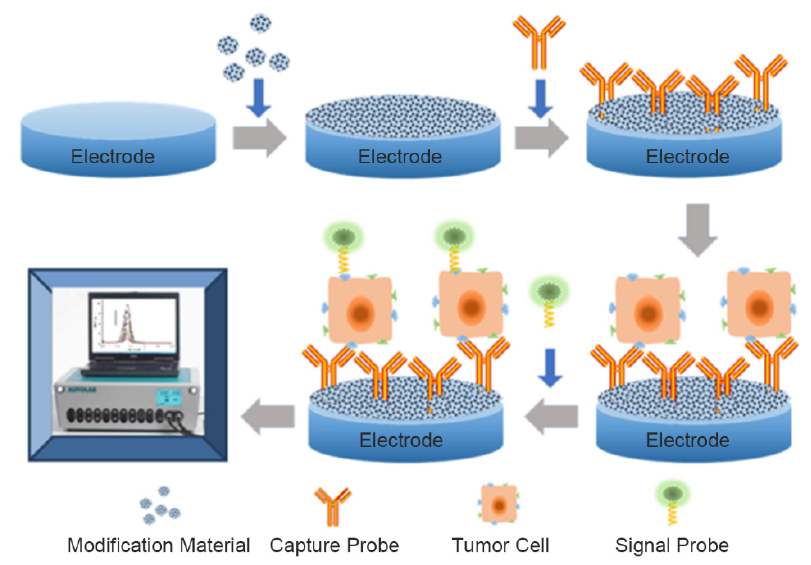
Figure 2. Composition of electrochemical cytosensors.